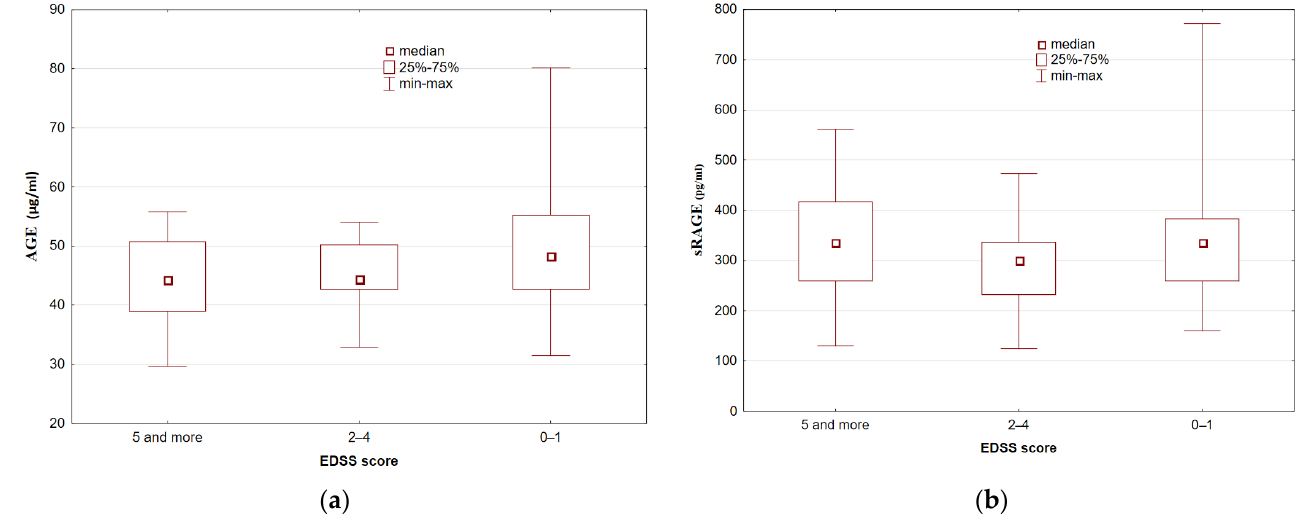
Figure 2. Serum AGE ( a ) and sRAGE ( b ) concentrations in MS patients depending on the EDSS score (Kruskal–Wallis rank ANOVA test: p > 0.05).